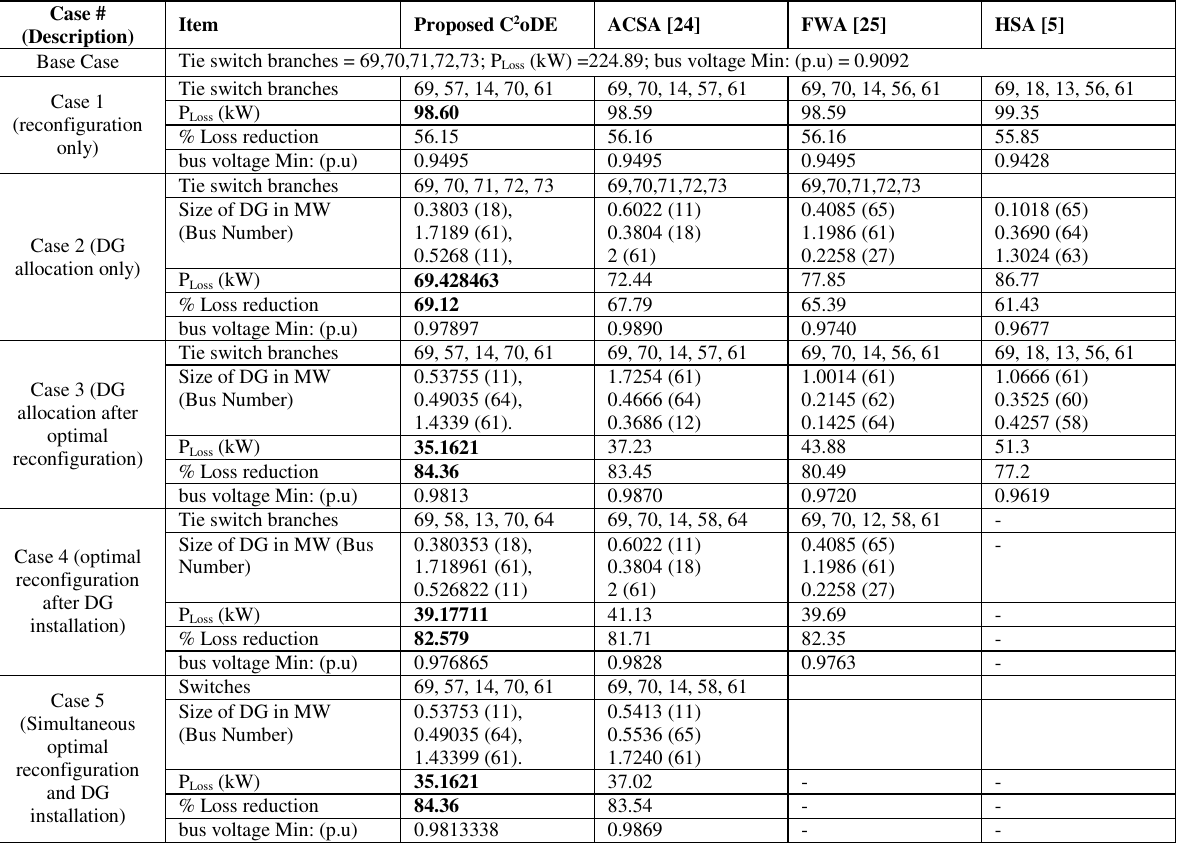
Table 6: Simulation Results of IEEE 69-Bus Test System